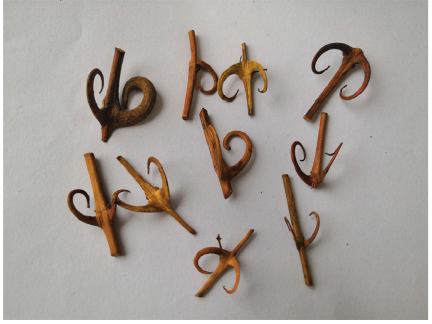
Figure 1: The dry stem with hook of